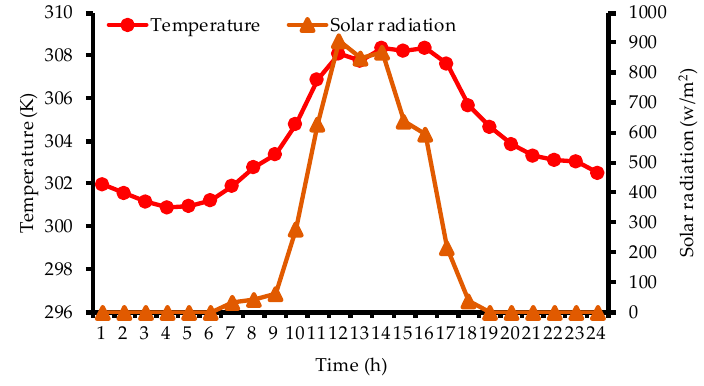
Figure 5. Ambient temperature and solar radiation.